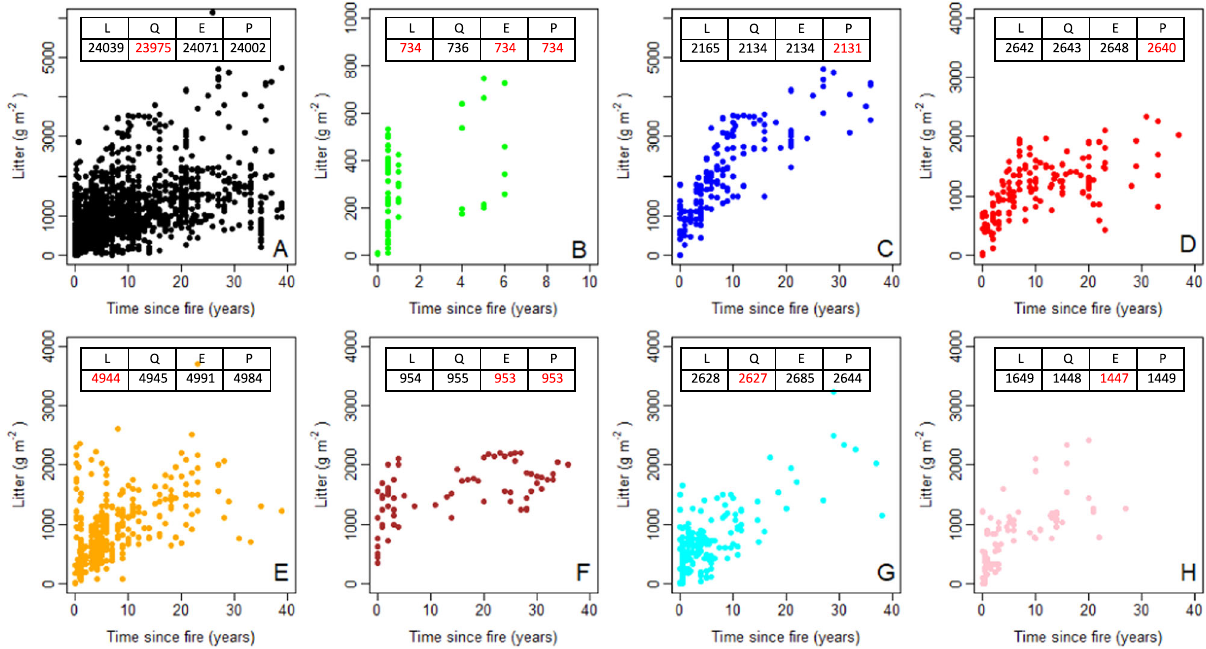
Fig.2|RelationshipoflittermasstoT sf (timesince fi re)foreucalyptforestsand woodlands. Panel A =All Eucalyptus . Panel B = E. miniata , C = E. diversicolor , D = Ash forests, E= E. marginata , F = E. pilularis , G =Grassy forests, H =Grassy wood- lands. For each data subset, we show Akaike ’ s Information Criterion (AIC) for each